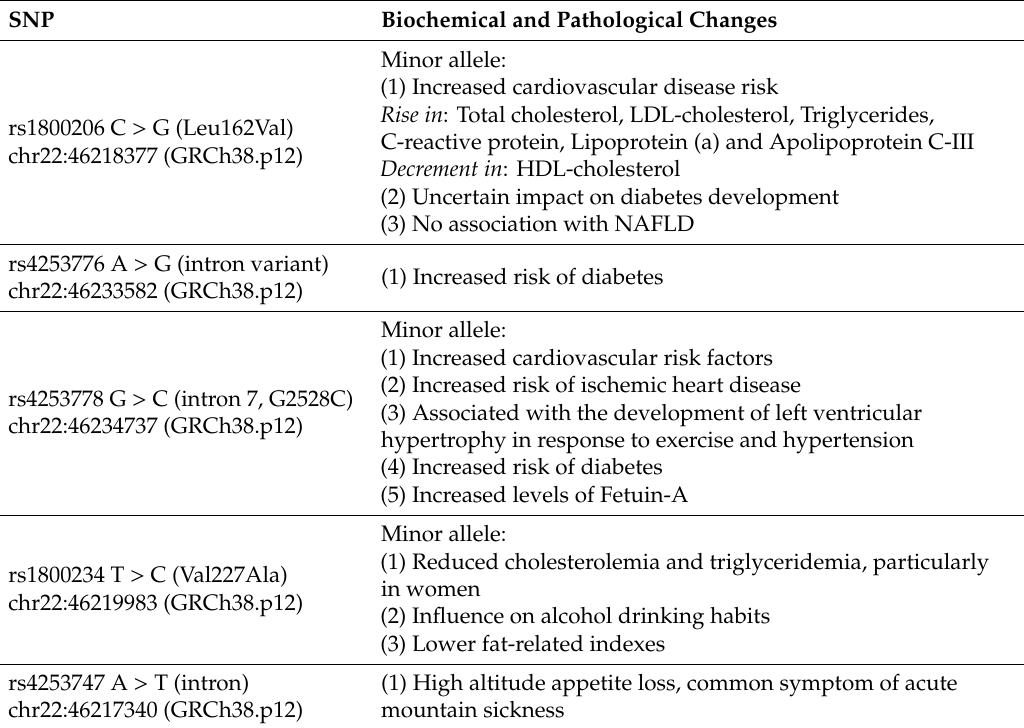
Table 1. Single nucleotide polymorphisms of PPAR α , location, and their potential interaction with biochemical